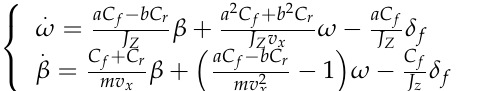
Figure 1. Linear two-degrees-of-freedom vehicle model.